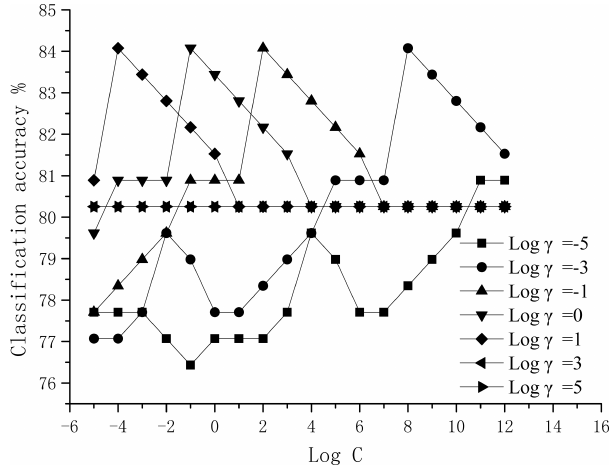
Fig. 5. Dependence of classi¯cation accuracy on parameters C and (cid:1) for a polynomial kernel SVM. The base of log C is 2 and the base of log (cid:1) is